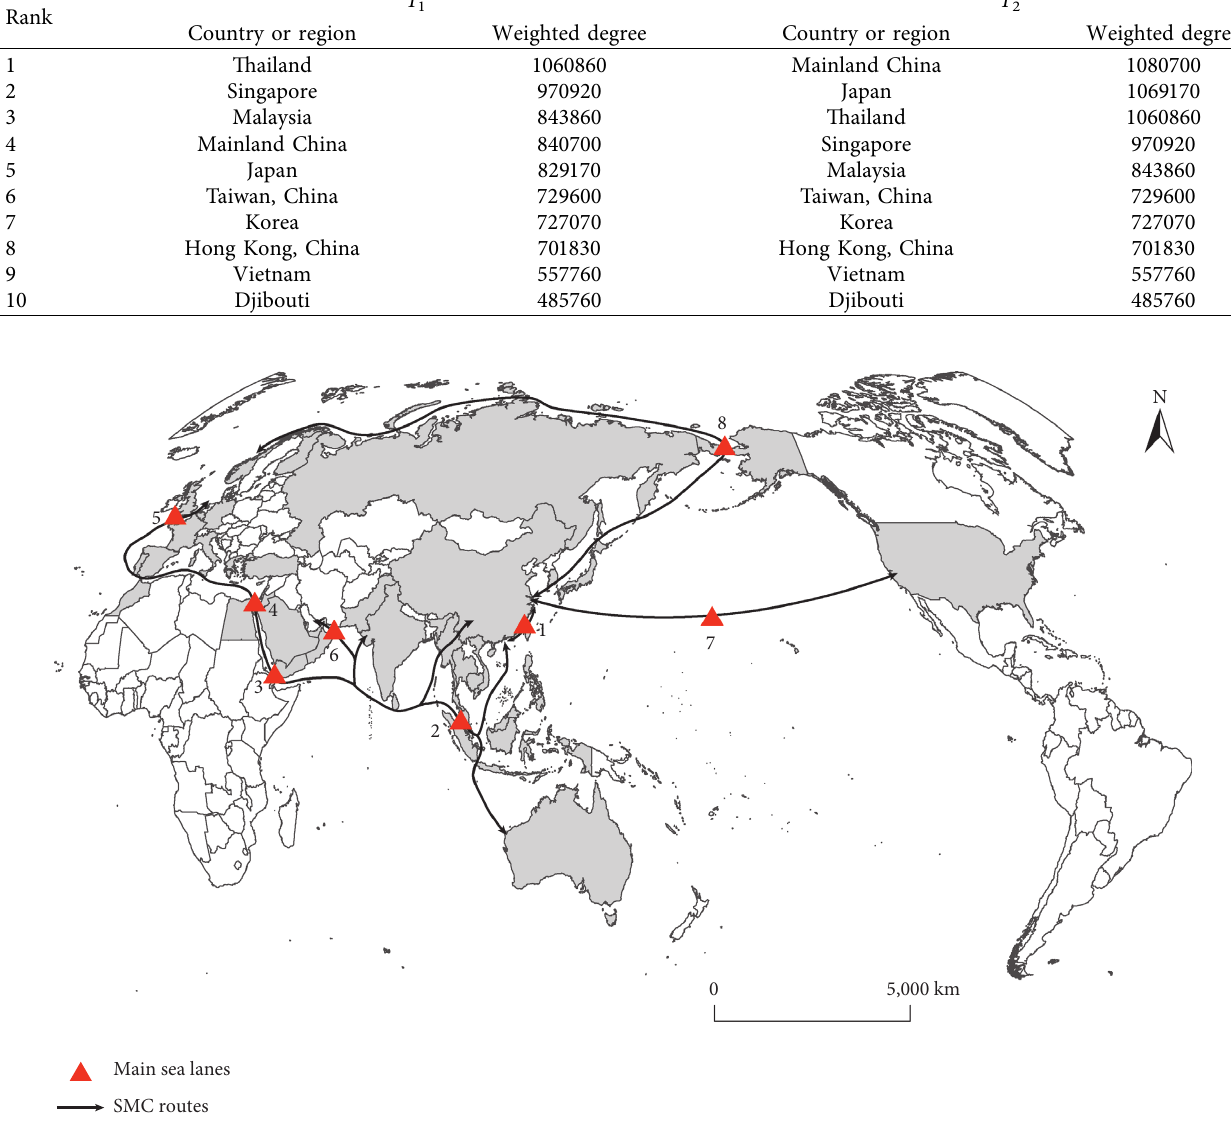
Figure 3: Location of main sea lanes (see Table 4 for the meaning of the numbers in Figure 3).